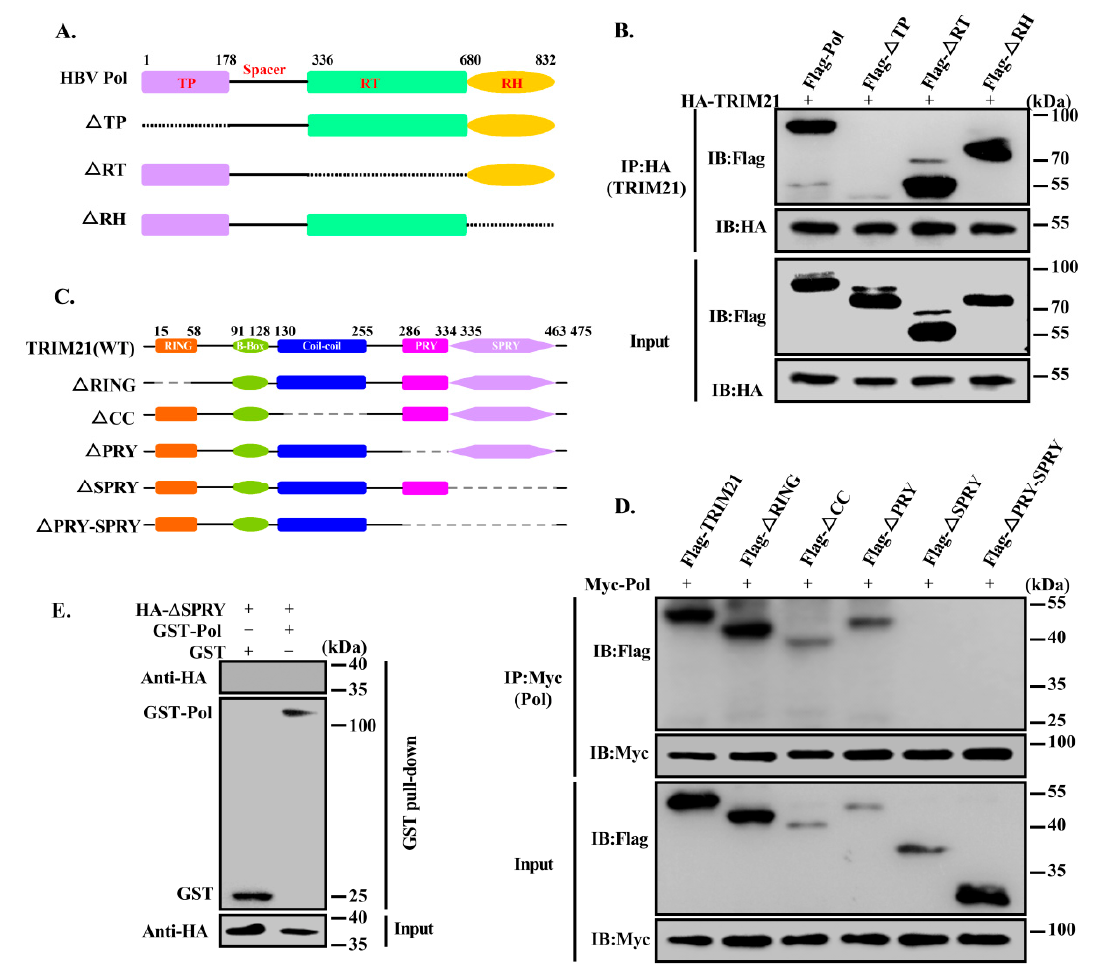
Figure 2. TRIM21 interacts with the TP domain of HBV DNA Pol via its SPRY domain. ( A ) Schematic map of the deletion mutants of HBV DNA Pol. ( B ) HA-TRIM21 was cotransfected with FLAG-HBV DNA Pol, ∆ TP, ∆ RT or ∆ RH. Anti-HA antibody was used for immunoprecipitation, and anti-FLAG antibody was used to detect the expression of HBV DNA Pol. ( C ) TRIM21 and its truncation mutants. ( D ) Huh7 cells were cotransfected with Myc-HBV DNA Pol and FLAG-TRIM21 or its truncation mutants, and co-IP was used to analyze the interaction of Myc-HBV DNA Pol with FLAG-TRIM21 or its truncation mutants. ( E ) GST-HBV DNA Pol and HA- ∆ SPRY were transfected into Huh7 cells, and 36 h post transfection, GST beads were used to pull down GST-Pol with its interacting proteins. HBV DNA Pol was detected with anti-GST antibody, and anti-HA antibody was used to detect the expression of ∆ SPRY. Data are representative of three independent experiments with three replicates